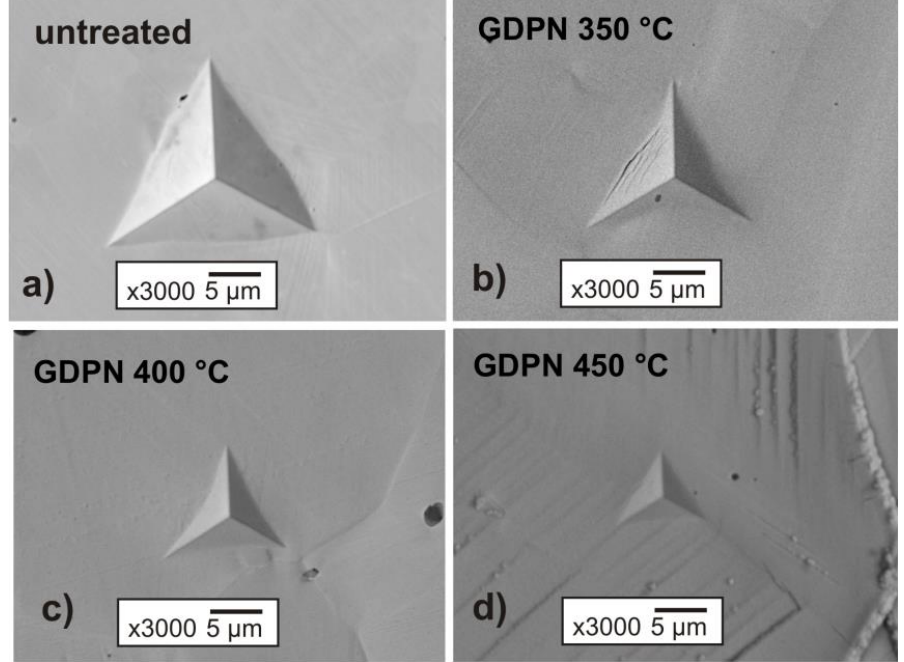
Figure 9. SEM micrographs of residual impressions produced by Berkovich tip indentation on untreated ( a ) and GDPN-nitrided ( b – d ) AISI 316 steel samples.